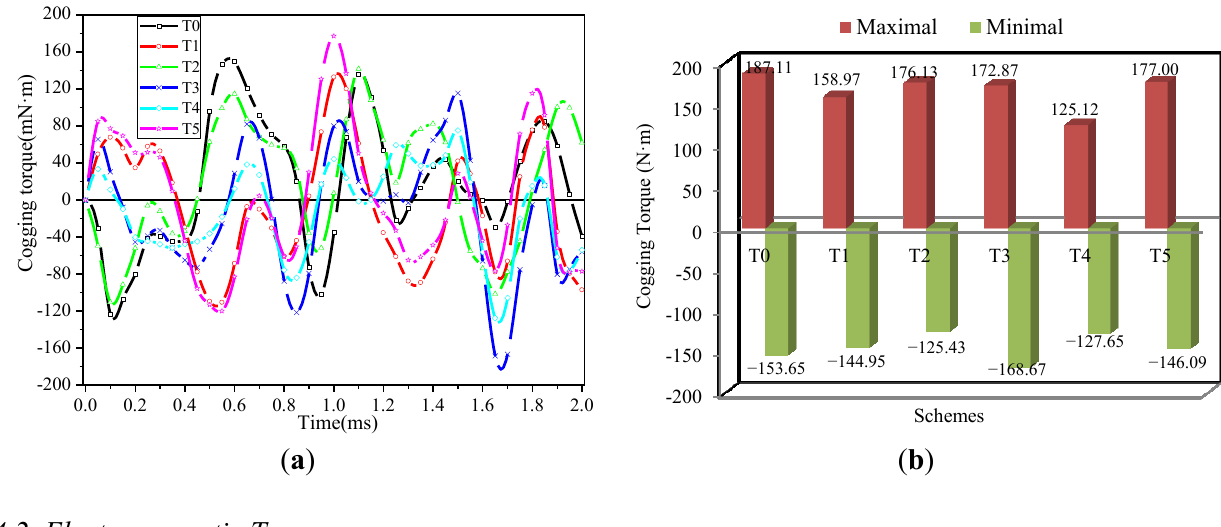
Figure 15. Cogging torque: ( a ) cogging torque at rated speed, 600 rpm; and ( b ) maximal and minimal